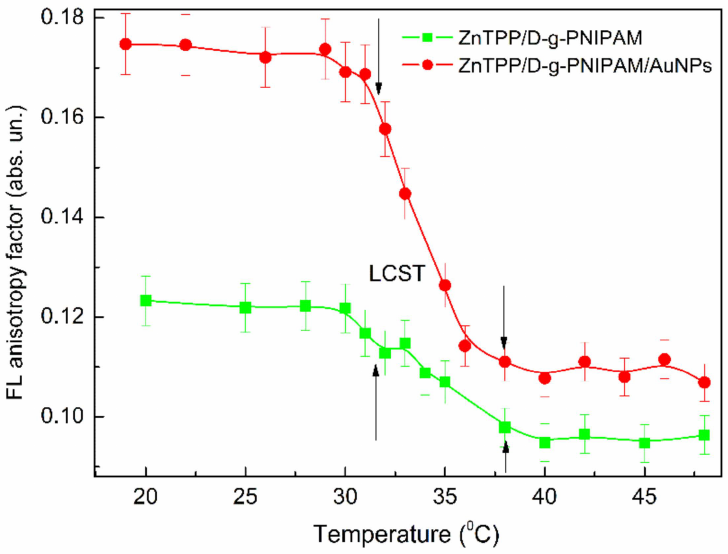
Figure 9. Temperature dependence of FL anisotropy factor for ZnTPP in aqueous solutions of ZnTPP/D-g-PNIPAM (squares) and ZnTPP/D-g-PNIPAM/AuNPs (circles) during heating. Arrows show the LCST transition range. Concentrations: ZnTPP—0.001 g/L, D-g-PNIPAM—0.078 g/L, Au—0.077